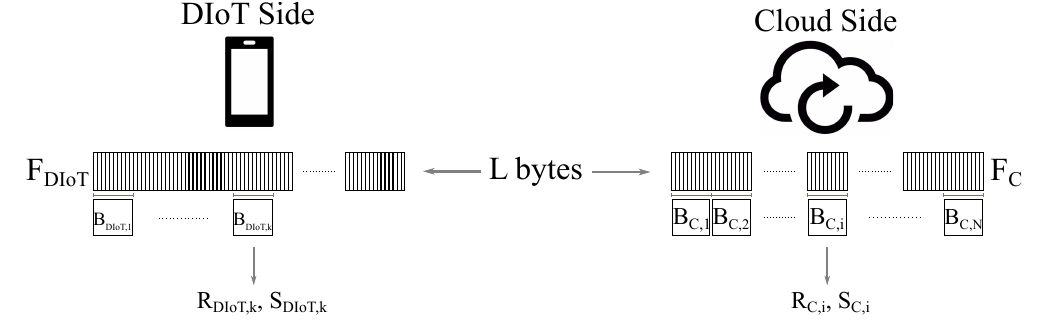
Figure 2. rsync procedure between DIoT and